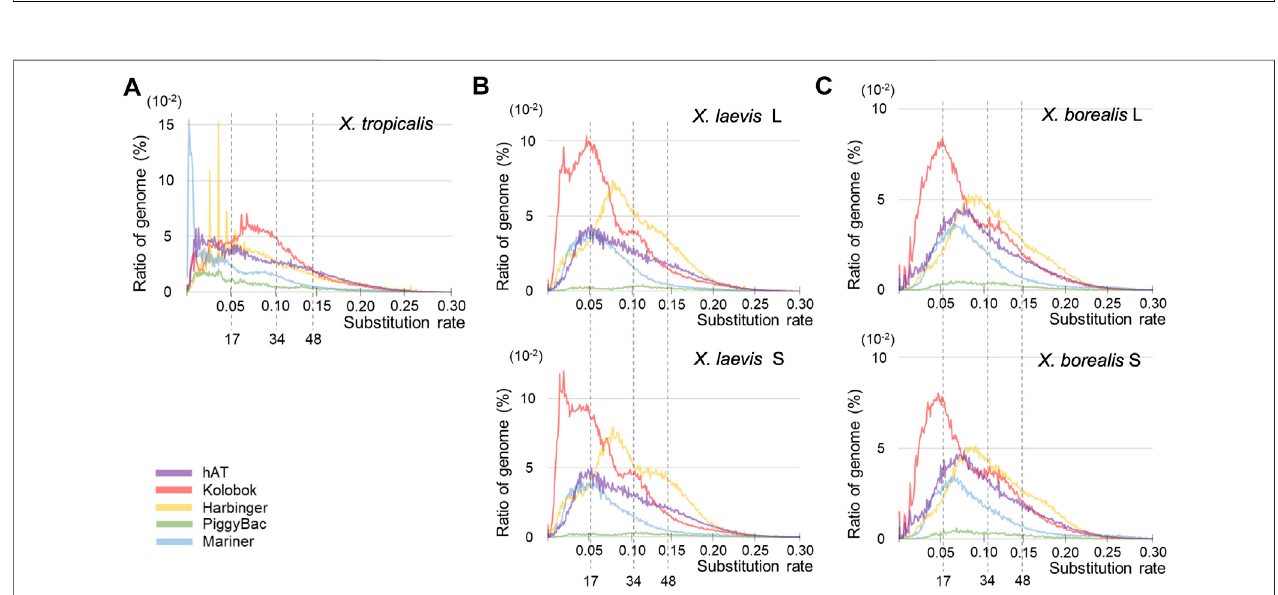
FIGURE 4 | Landscapes of sixmajor superfamilies ofDNA transposonsin the three Xenopus species. The substitution ratio of each superfamily in X. tropicalis (A) , X.laevis LandS (B) ,and X.borealis LandS (C) areshownonthehorizontalaxis.Proportion(%)ofthetransposonstoeachgenomeDNAareshownontheverticalaxis.